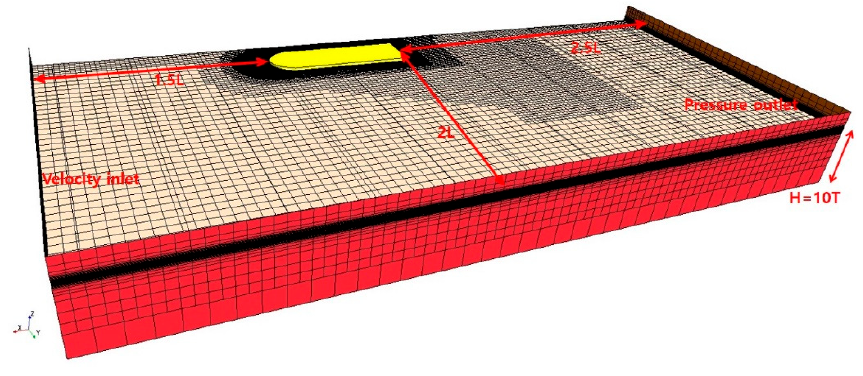
Figure 1. Calculation domain and grid system.